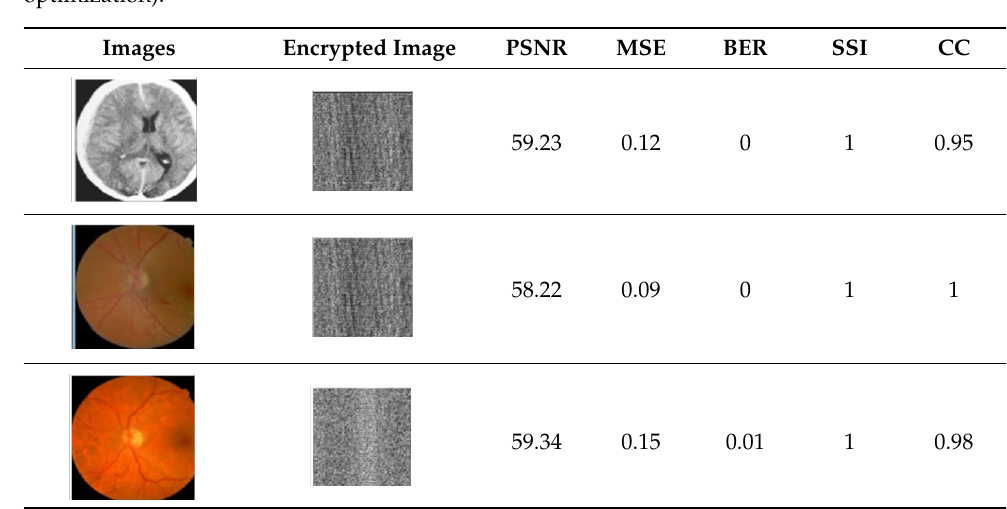
Figure 3. Images from a sample database for the suggested model of ( a ) The brain image, ( b ) Glaucoma image, ( c ) Echocardiography image. coma image, ( c ) Echocardiography image. Table 1. Results of the proposed model (hostile orchestration and obstruction bloom breeding